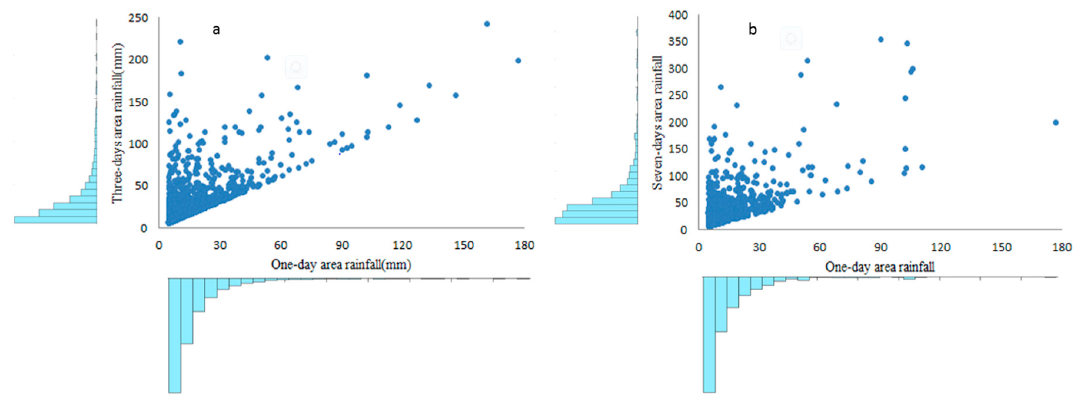
Figure 2. Scatter plots of the one-day and multi-day rainfall with marginal histograms. ( a ) one-day and three-day rainfall ( b ) one-day and seven-day rainfall.